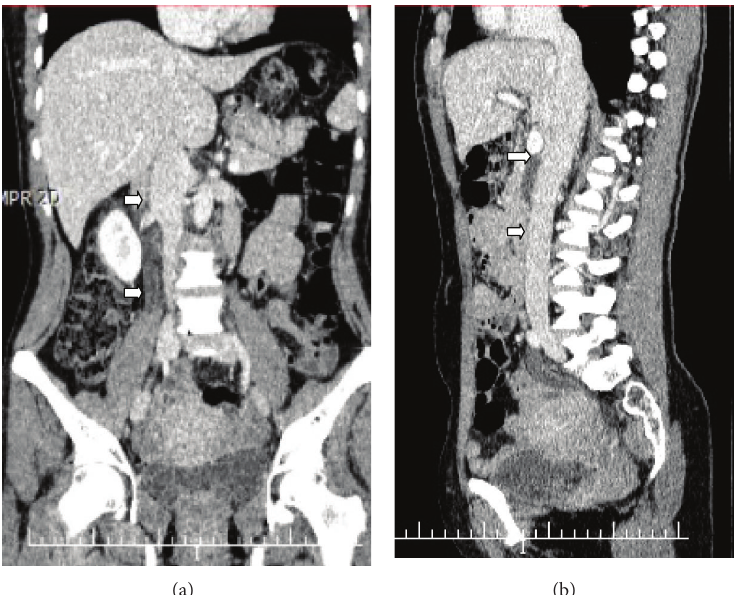
Figure 4: (a) Coronal and (b) sagittal images of CT with contrast enhancement revealed that OV and IVC is patent at the 12th month of OVT with no collateral